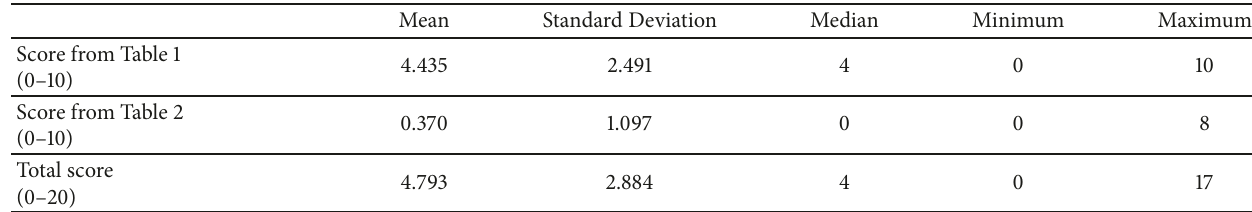
Table 5: Total average scores of the videos included in this study